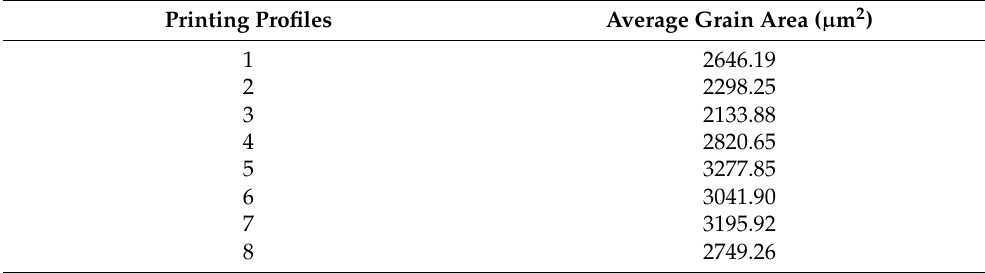
Table 7. Average grain area for the eight printing configurations (Red lines in Figure 5).